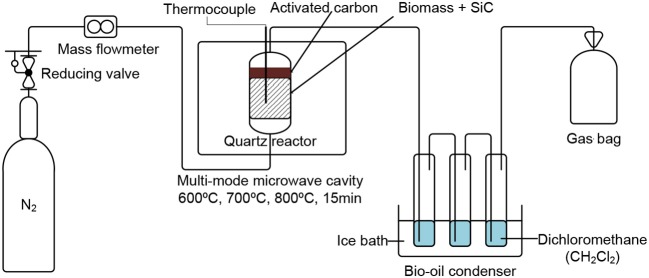
Schematic of microwave-assisted pyrolysis of biomass coupled with reforming.